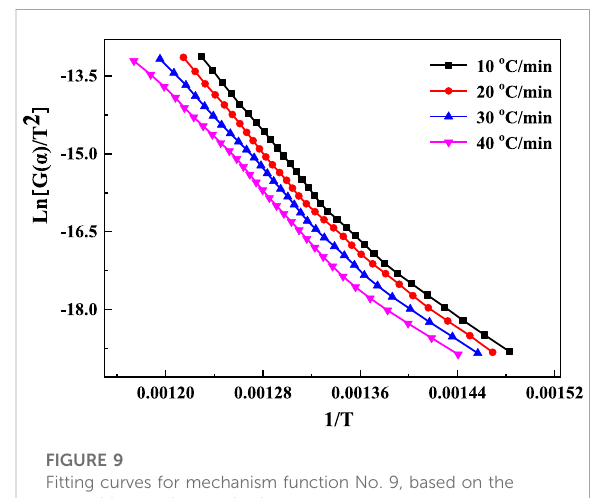
FIGURE 9 Fitting curves for mechanism function No. 9, based on the general integration